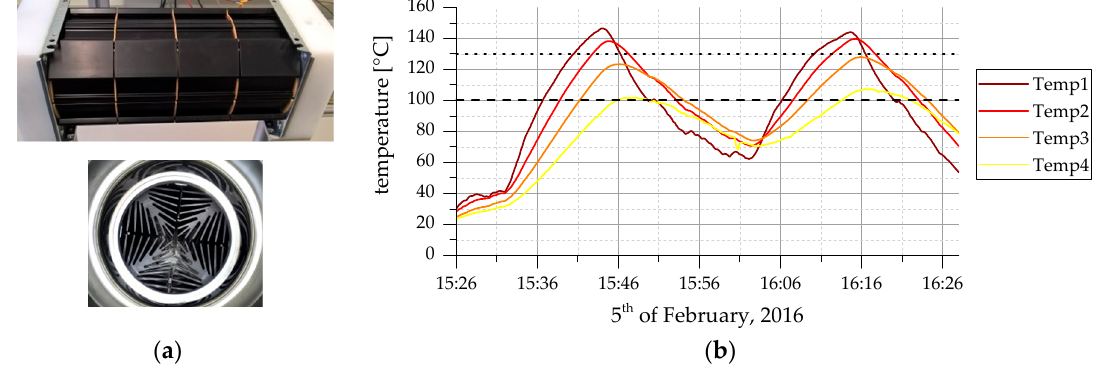
Figure 5. Thermal design to collect the heat: ( a ) segment cooling aggregate to extract heat from flowing medium; ( b ) Temperature measurement of each section of the segment cooling aggregate for a 20/80 heating load.